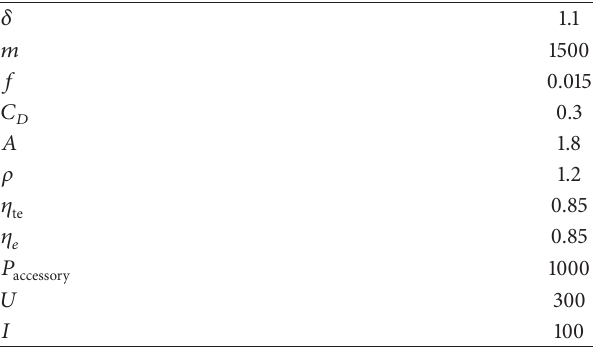
Table 1: The values of the vehicle’s related